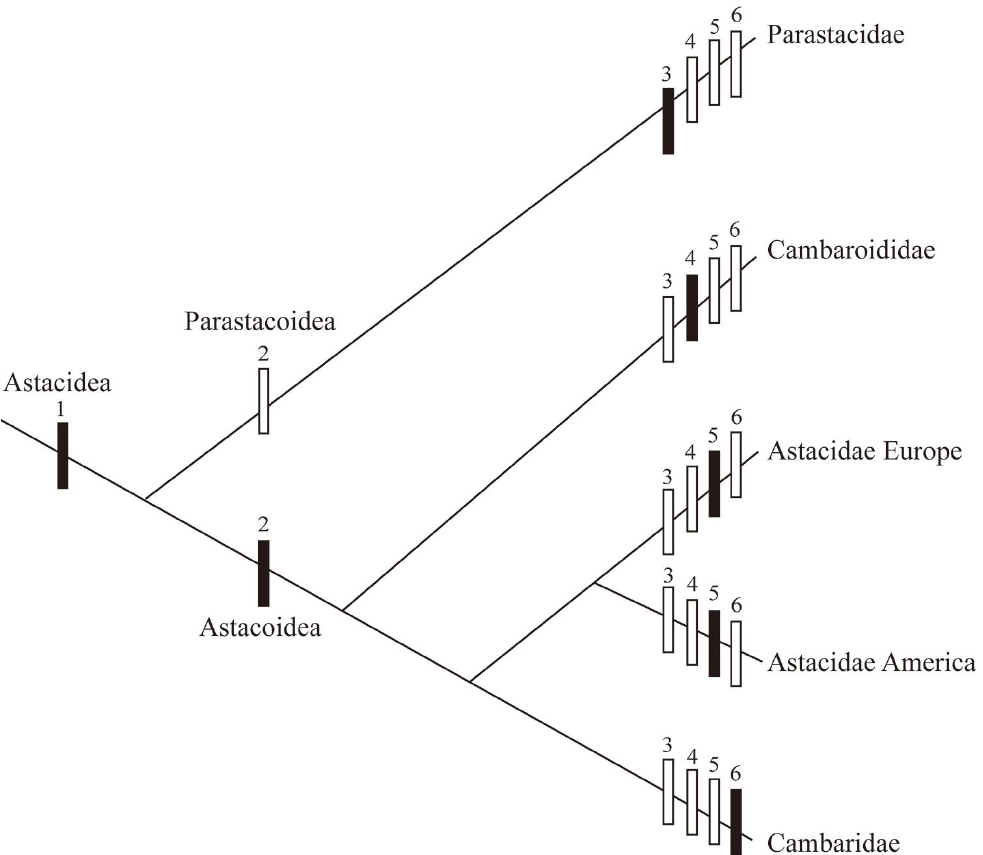
Figure 25. Phylogenetic tree of freshwater crayfish, Astacidea, with diagnostic morphological features in postembryonic stages. Basic phylogenetic tree constructed using recent molecular studies (Crandall et al. , 2000; Porter et al. , 2005; Bracken et al. , 2009; Breinholt et al. , 2009; Pérez-Losada et al. , 2010; Toon et al. , 2010; Stern and Crandall, 2016; Crandall and De Grave, 2017; Grandjean et al. , 2017; Wolfe et al. , 2019). The bars on the tree represent the juvenile morphology as given in Tab. 1; a solid bar means presence and an open vertical bar absence. Numbers on the bar: 1: compound sessile eye in Stage I and developed eye stalk in Stage II; globular carapace in Stage I lost in Stage II; teeth and processes absent in Stage I but present in Stage II; setae absent on pereiopod in Stage I and long setae present in Stage II; 2: setae absent on antenna 1 and 2 with antennal scale in Stage I, and seta present in Stage II; no setae at tip of the exopodite of the maxilliped in Stage I; the plumose setae appear in Stage II; curved hook on terminal end of the pereiopod absent in Stage II; telson with plumose setae along cephalic margin; 3: maxilla 2 with 1 or 3 long setae in Stage II; 4: maxilla 2 with 2 long setae in Stage II; 5: maxilla 2 with 1 long setae in Stage II; 6: maxilla 2 with no long setae in Stage